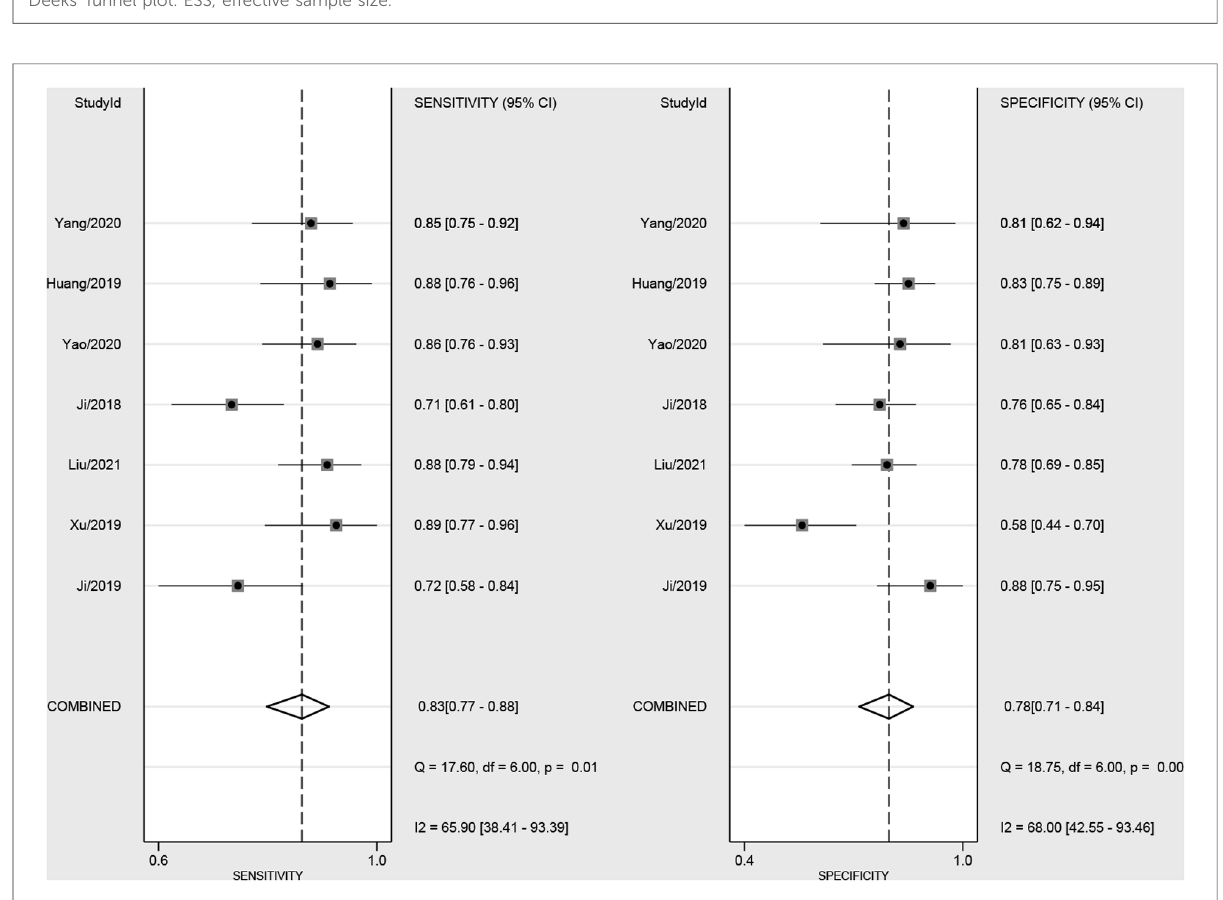
FIGURE 4 Forest plot of sensitivity and speci fi city based on radiomics for preoperative prediction of LMN in